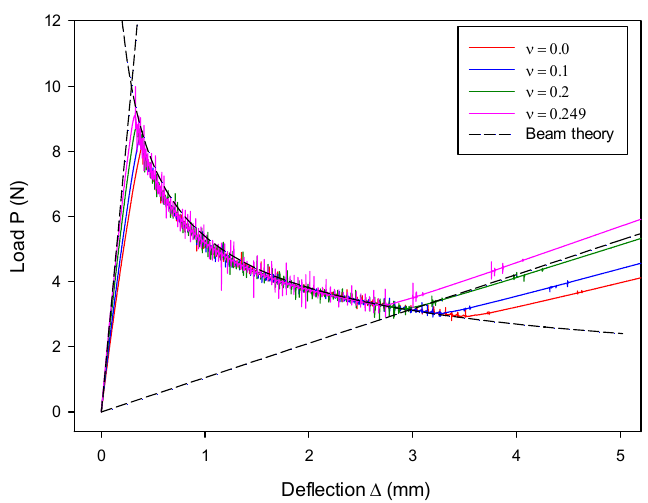
Figure 15. Poisson’s ratio effect on load–deflection relation.